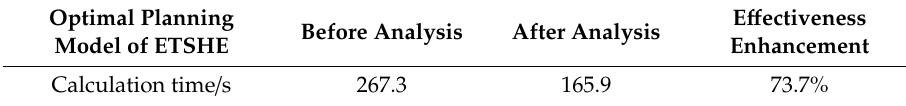
Table 7. Comparison analysis before and after node sensitivity analysis.